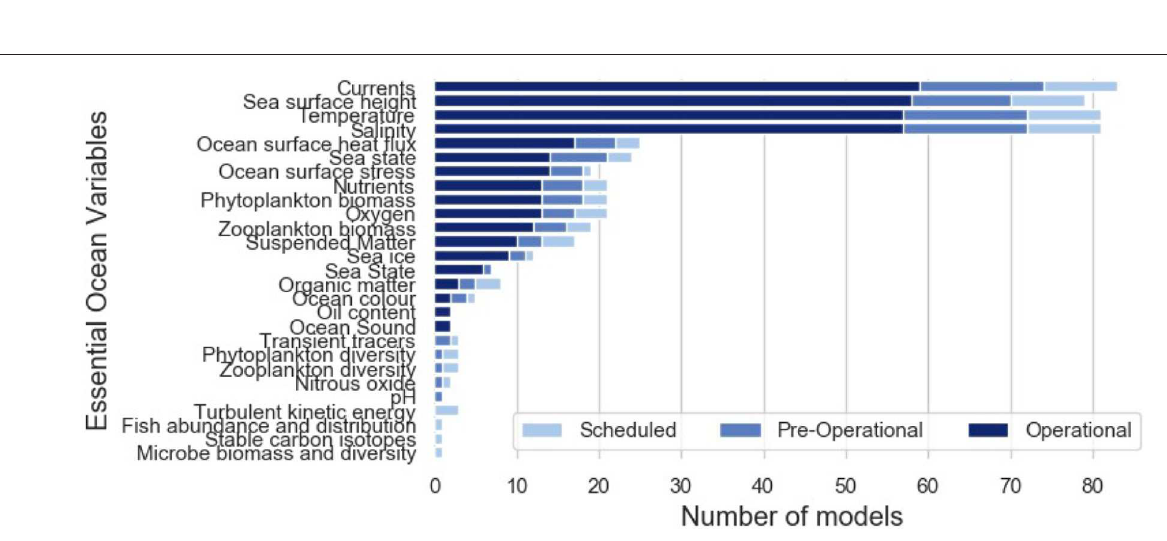
FIGURE 4 | Number of operational, pre-operational, and scheduled model implementations providing quantitative results for each Essential Ocean Variable (EOV).